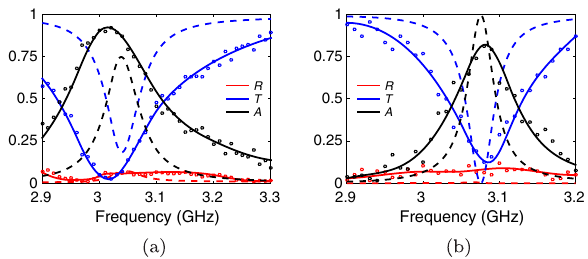
FIG. 10. Measured and the corresponding simulated reflection, transmission, and absorption coefficients for the fabricated metasurfaces with (a) single- and (b) double-turn helical inclu- sions. The dots denote measured values. The solid lines are the envelope curves of the measured data. The dashed lines show the corresponding simulated coefficients of the measured